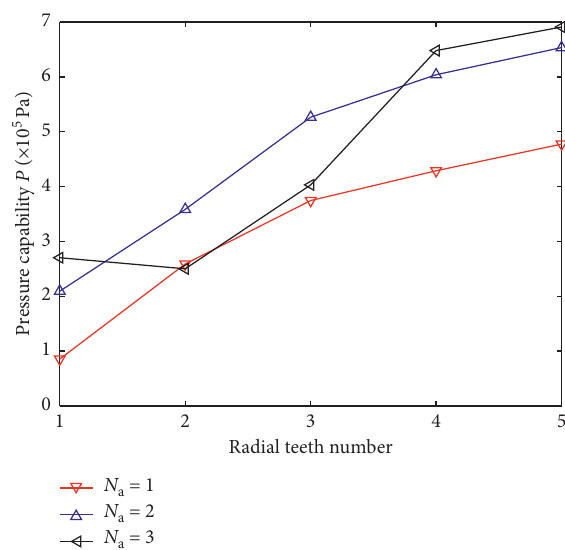
Figure 10: Magnetic field distribution with different teeth number in the axial sealing position. N a : axial teeth